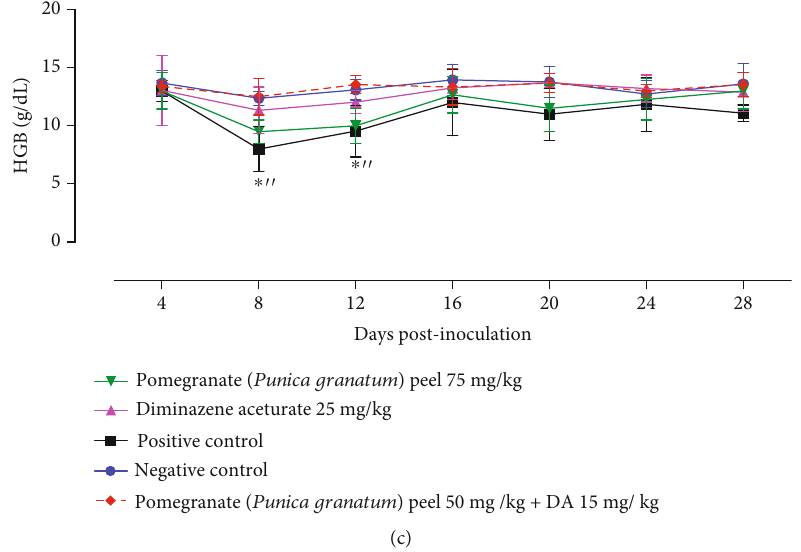
Figure 3: Hematological variables in B. microti -infected mice treated with pomegranate ( Punica granatum ) peel. (a) Hematocrit (HCT). (b) RBCs. (c) Hemoglobin (HGB). The values are presented as mean and SD of the mice used in each group. The signi fi cant di ff erence ( P < 0 : 05 ) between the used groups is indicated by